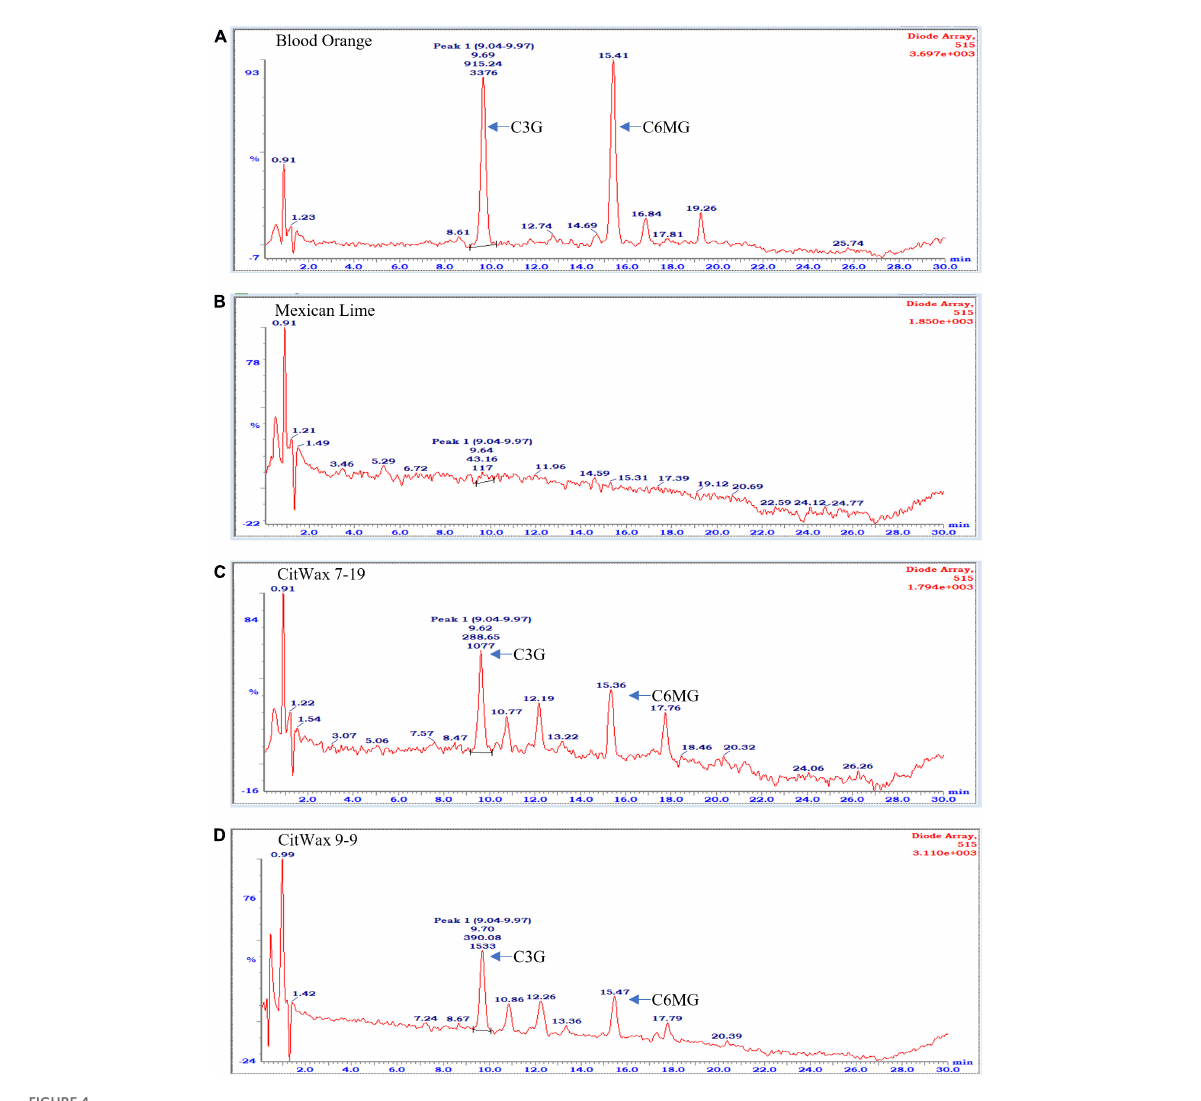
FIGURE4 Chromatographic profile of anthocyanins found in citrus fruits. (A) Commercially bought Moro blood orange. (B) Wildtype Mexican lime. (C) Transgenic CitWax 7-19. (D) Transgenic CitWax 9-9. Cyanidin 3-glucoside (C3G) and cyanidin 3-(6 (cid:48)(cid:48) -malonyl)- β -glucoside (C3-6MG) provide the two strongest and peaks at approximately 9.6 and 15.4 min with UV-Vis absorption at 515